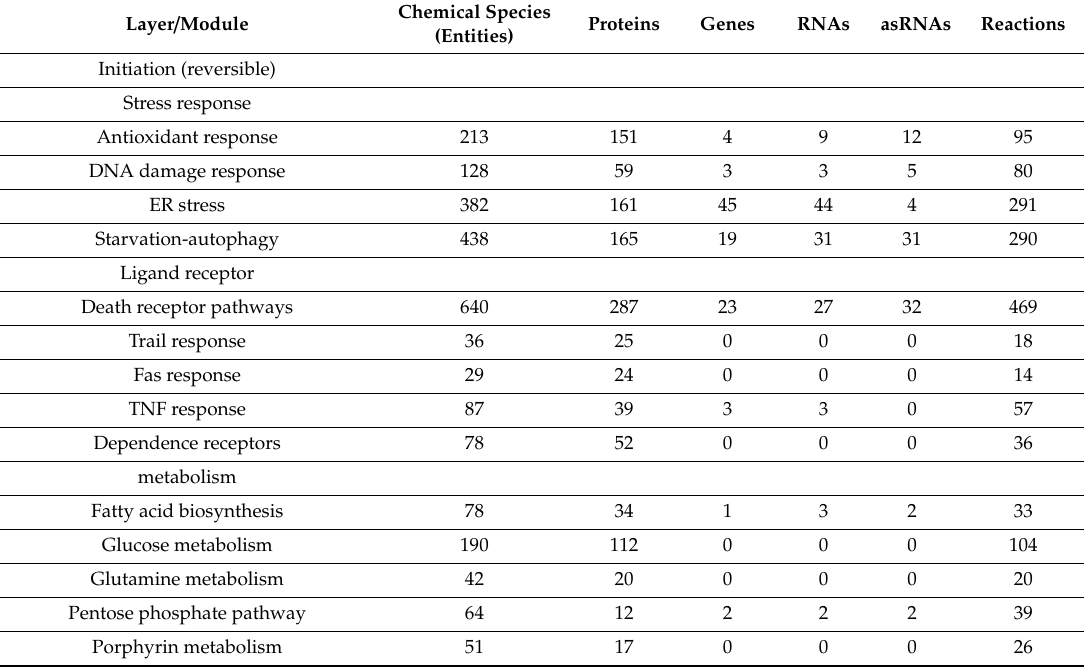
Figure 2. Regulated cell death map browsing, zooms, and entities annotations. ( A ) Map interface in NaviCell-powered Google Maps platform with a top view layout of RCD map. The interface includes the map window, selection panel, data analysis panel and upper panel. Map querying is possible via the search window or by checking on the entity in a list of entities in the selection panel that will drop markers all over the map (for example, Caspase 9). ( B ) Zoom of a fragment of the map and callout window. Clicking on a marker opens a callout window containing three sections: “Identifiers” with links to external databases; “Map Modules” with links to functional modules where the entity of interest is found, “References” with links to PubMed, and annotation notes. Clicking on the “globe” icon opens the corresponding map. Clicking on a “book” icon opens a detailed annotation page. ( C ) Zoom of a fragment of a module showing the most detailed level of the representation of molecular mechanisms. The participation of the selected molecule (e.g., caspase 9) in various reactions and complexes can be seen. Table 1. Structure and content of the RCD map.